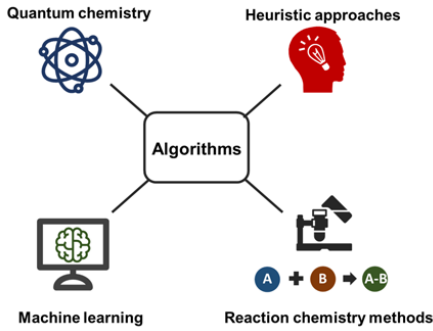
Figure 1. Computational metabolomics approaches help to unravel the complexity of the metabolome and especially shed light on unknown metabolites. This includes technologies across different disciplines, including quantum chemistry, machine learning, heuristic approaches and reaction chemistry-based